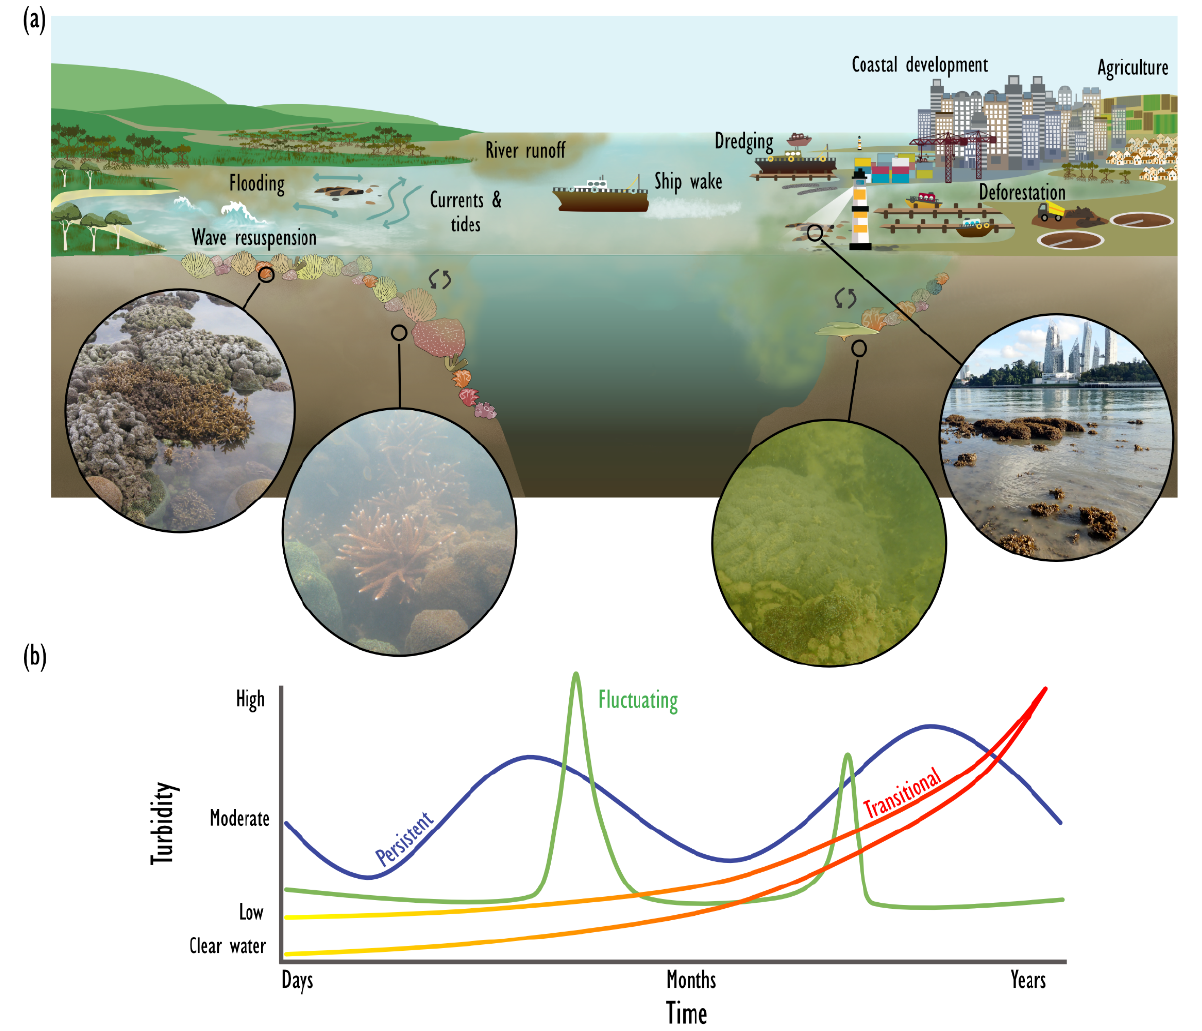
Figure 1. ( a ) Natural turbid reef (on the left, two photos of PSRC by Nicola Browne) and VS anthropogenic turbid reef (on the right, two photos of Singapore reefs by Kyle Morgan). ( b ) Types of turbidity regimes on a temporal scale: persistent (blue), fluctuating (green) and transitional (yellow-red). y axis turbidity scale: low (<5 mg L − 1 /<15 NTU), moderate (5 mg L − 1 /15 NTU) and high (>50 mg L − 1 />150 NTU).